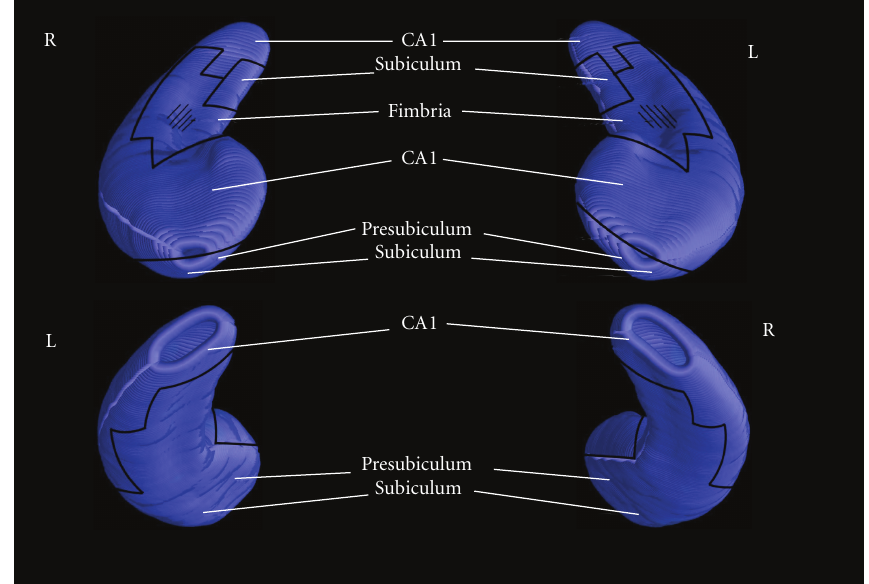
Figure 1: Cytoarchitectonic subregions mapped on blank MR-based models of the hippocampal formation of a healthy subject.